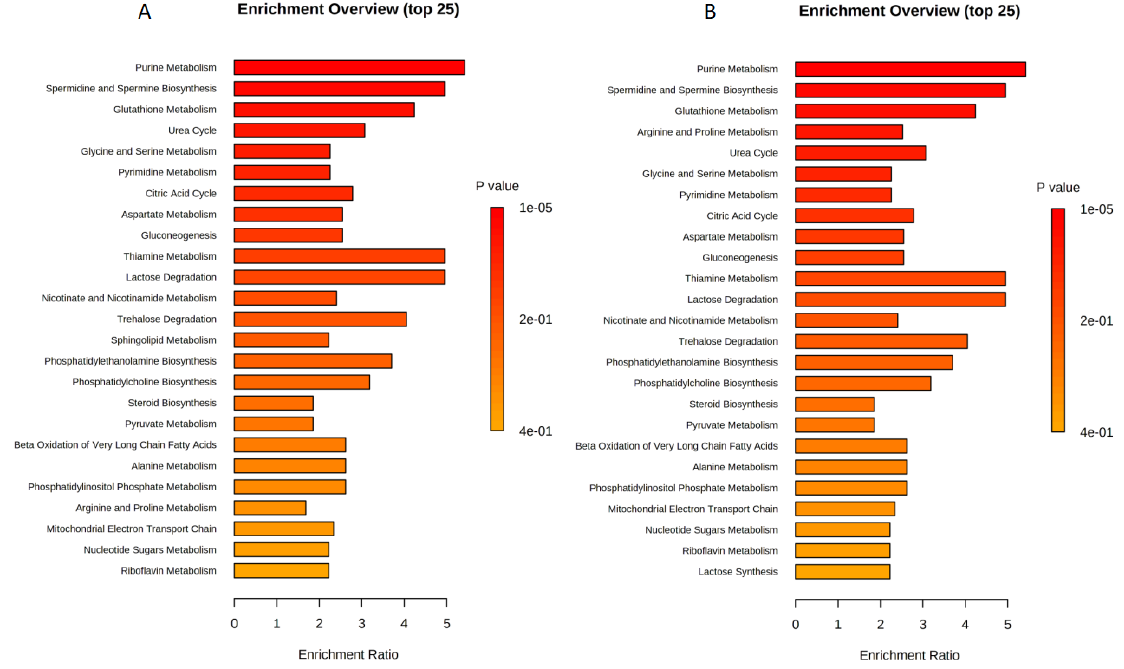
Figure 3. Enrichment analysis for ( A ) DMSO with paclitaxel 4.2 nM; ( B ) DMSO with (paclitaxel 4.2 nM + etoposide 10 µg/mL) in U87 cell line.